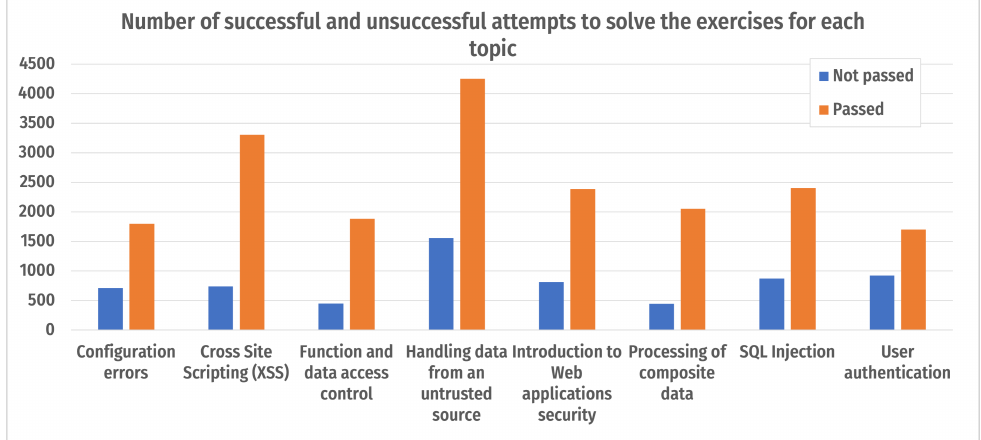
Figure 11. Number of successful and unsuccessful attempts to solve the exercises for each